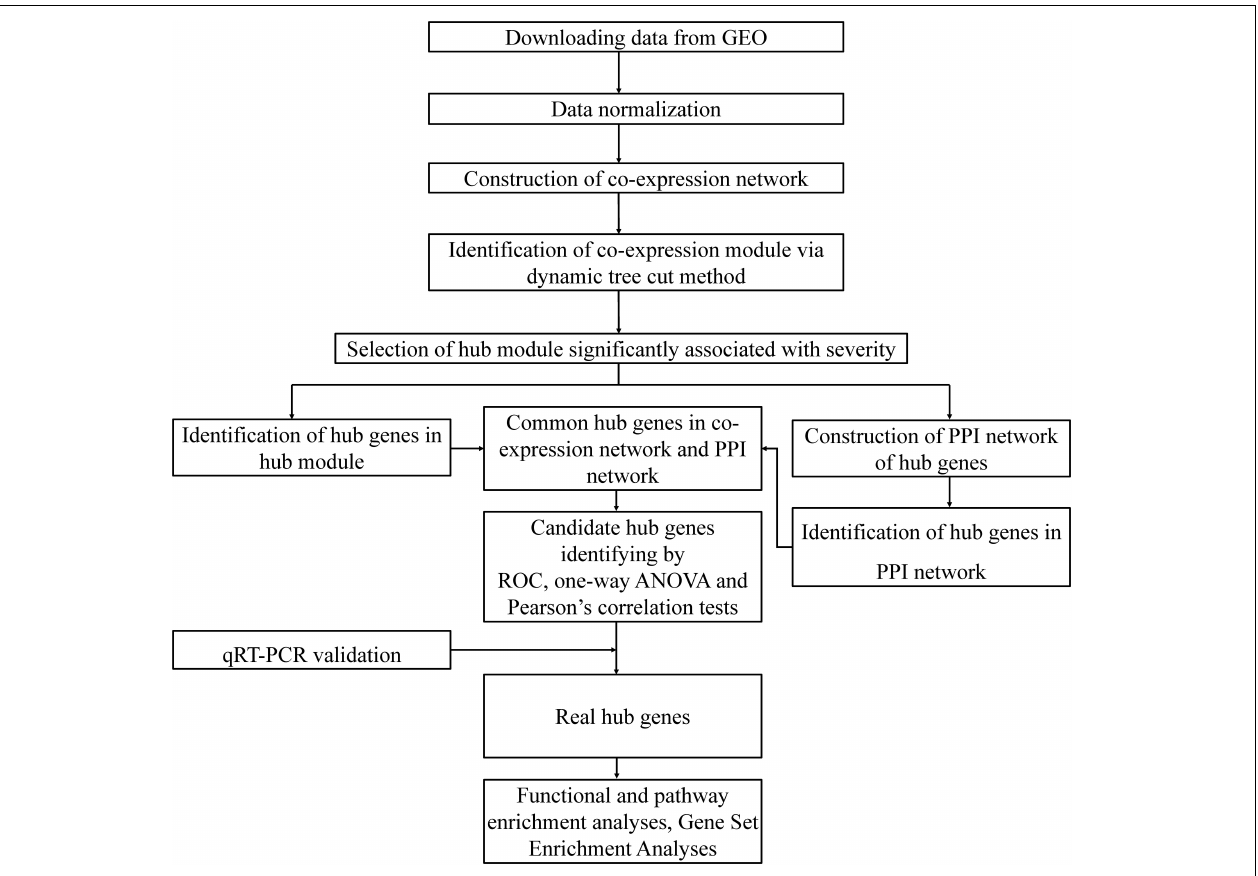
FIGURE 1 | Outline of the study